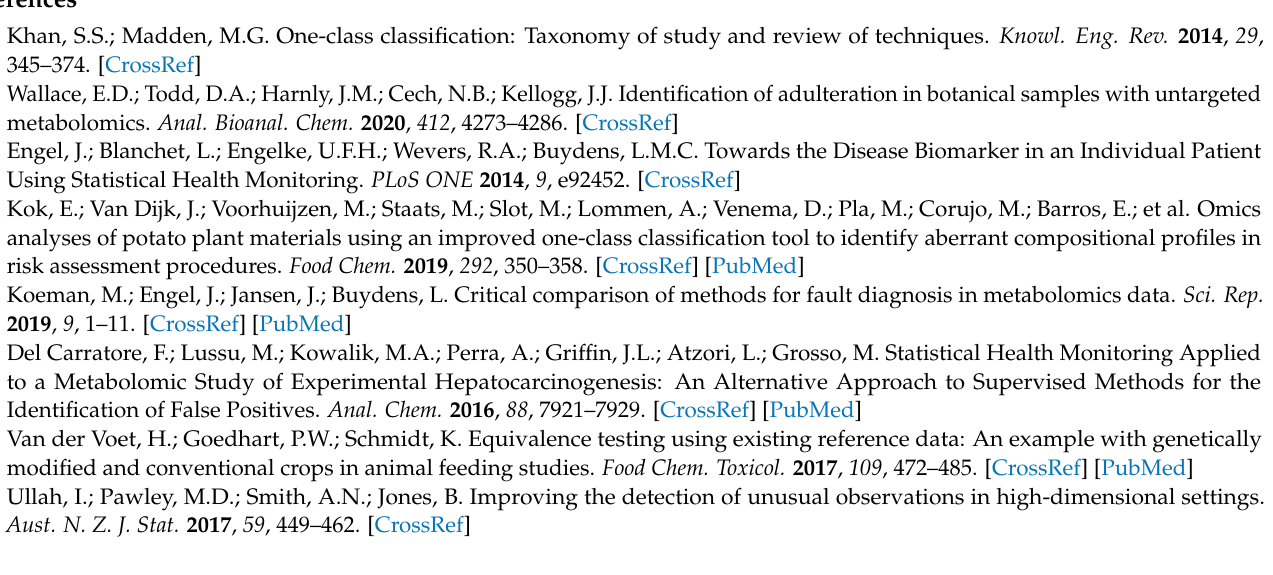
for the standard PCA-based decision criteria (simulation 2), Figure S9: Heatmaps of the population correlation matrices, Table S10: overview of the potato samples analyzed in case study 2, Figure S11: R script example, Table S12: MD sample statistics (over 1000 simulations) based on “LW” shrinkage as a function of the sample size of the reference set, Figure S13: Type I error (over 200 simulations) for the “L W” eigenvalue shrinkage approaches for the MD with χ 2 - or bootstrap-based critical limits for a P-variate normal distribution with 0 mean and type (i) covariance matrix (P =